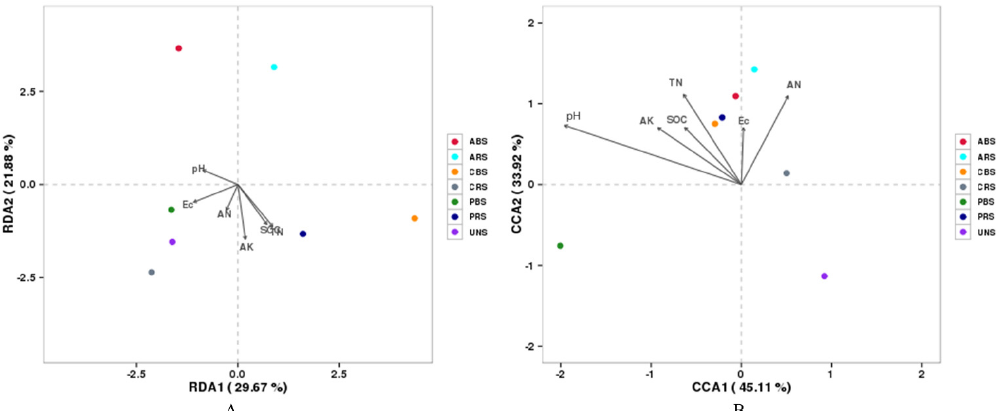
Figure 5. Regression analysis of correlation between bacterial ( A ) and fungal ( B ) composition of soil samples and environmental factors. The scale on the horizontal and vertical coordinates is the value generated by each sample during regression analysis and calculation with environmental factors; dots represent soil samples; arrows represent different environmental factors. The relationship between element points is represented by distance. CRS/CBS = rhizosphere soil/bulk soil of C. lanceolata ; PRS/PBS = rhizosphere soil/bulk soil of P. elliottii ; ARS/ABS = rhizosphere soil/bulk soil of A. cremastogyne ; UNS = uncontaminated soil.